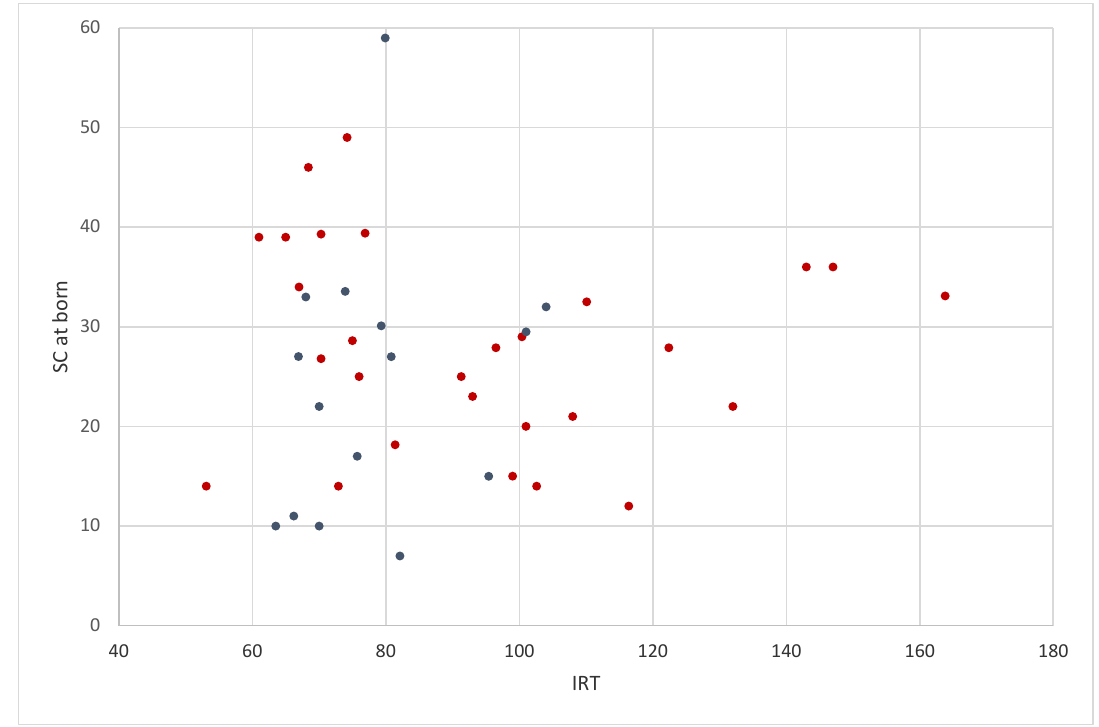
Figure 1. IRT (ng/mL) and first sweat chloride (mmol/L) values of 43 CRMS/CFSPID subjects (in red for infants of group A and in blue for infants of group B).